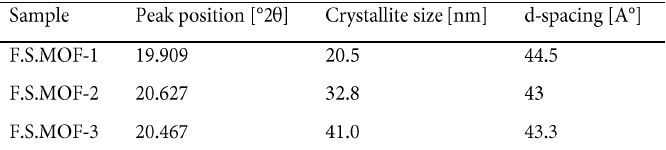
Table 2. XRD parameters of nanocomposites